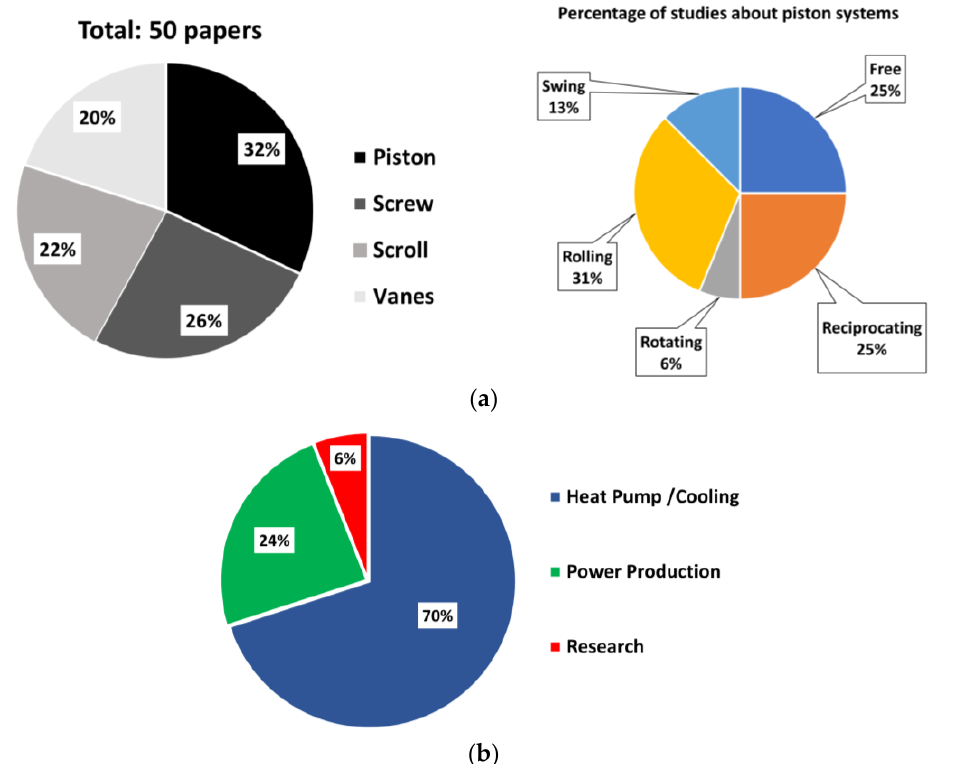
Figure 18. Results from the literature analysis, showing an investigation of the expander technologies ( a ) and of their applications ( b ).